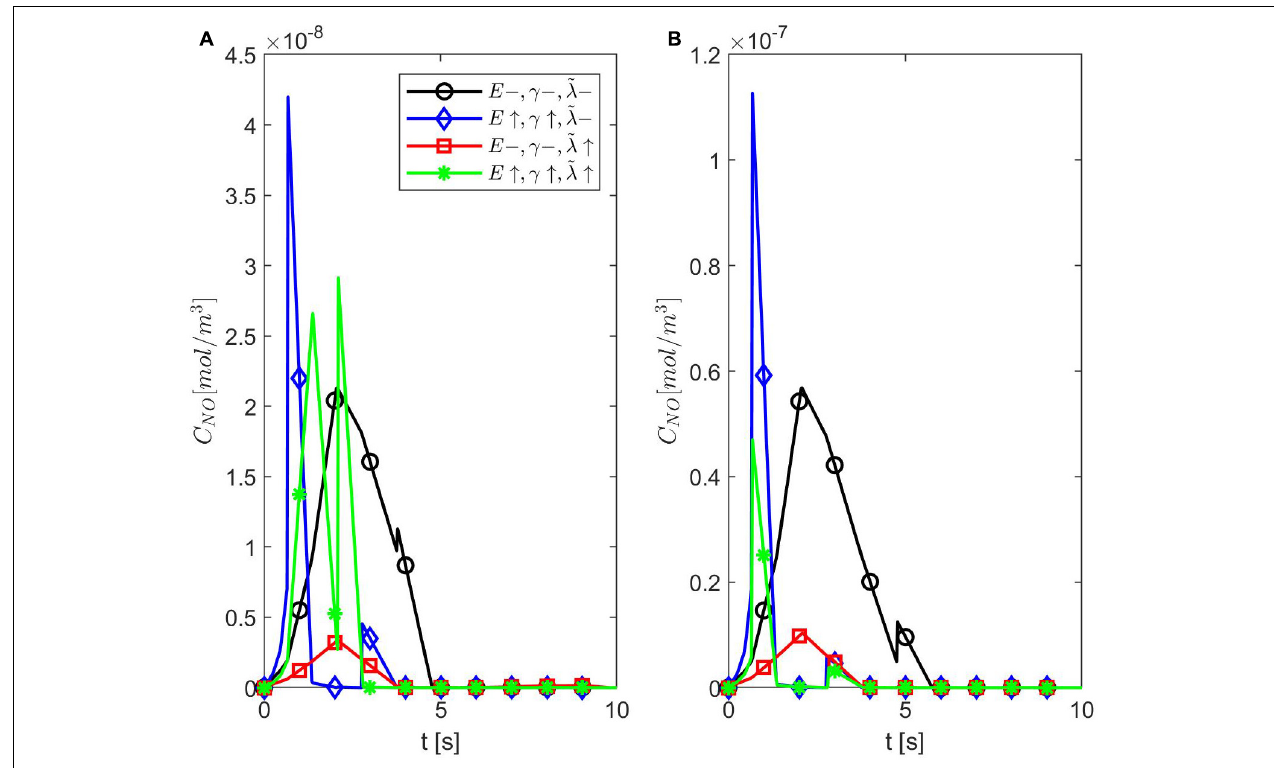
FIGURE 9 | Temporal profiles of C NO at r = a + h , the outer boundary of the endothelium, for ε = 0 . 95 , (A) p = 0 . 75 ( q = 0 . 25 ) , and (B) p = 0 . 25 ( q = 0 . 75 ) ( A,B have the same legend shown in A ). Here E = 6 × 10 3 N / m , γ = 0 . 75 , ˜ λ = 6 . 5325 × 10 3 s − 1 (black circle symbol), E = 6 × 10 4 N / m , γ = 1 . 25 , ˜ λ = 6 . 5325 × 10 3 s − 1 (blue diamond symbol), E = 6 × 10 3 N / m , γ = 0 . 75 , ˜ λ = 13 . 065 × 10 3 s − 1 (red square symbol), and E = 6 × 10 4 N / m , γ = 1 . 25 , ˜ λ = 13 . 0655 × 10 3 s − 1 (green star